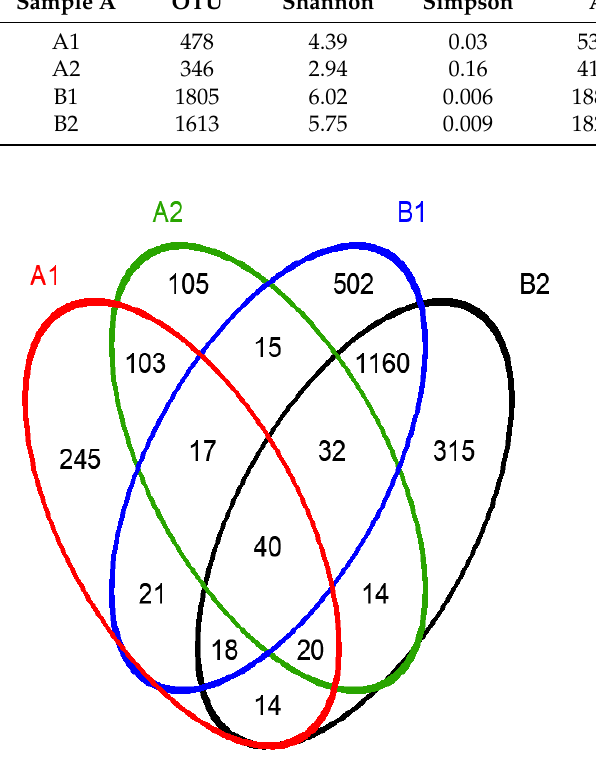
Figure 3. OTU Venn analysis of sample A1–B2.